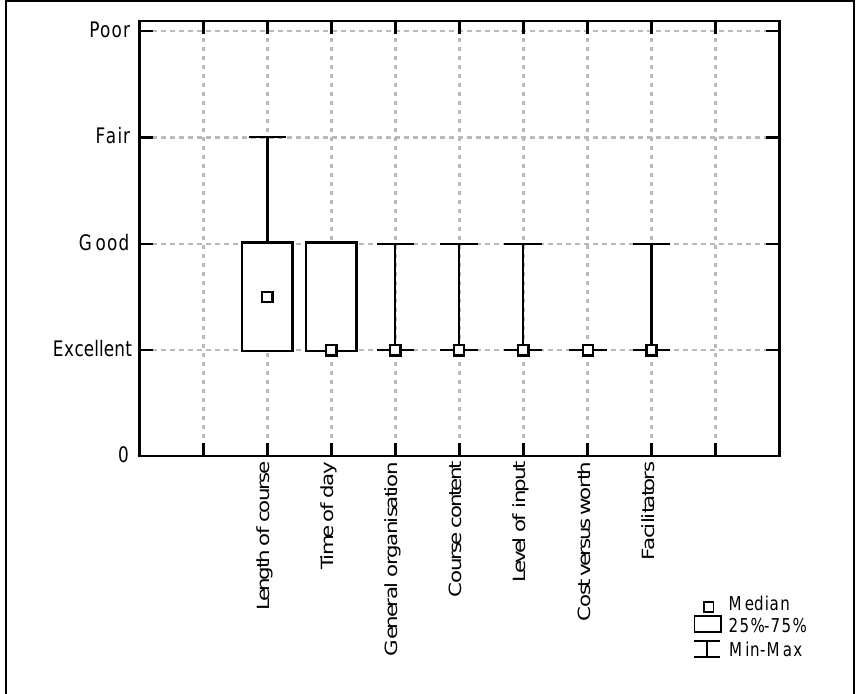
Figure 5: Participants’ rating of the workshop